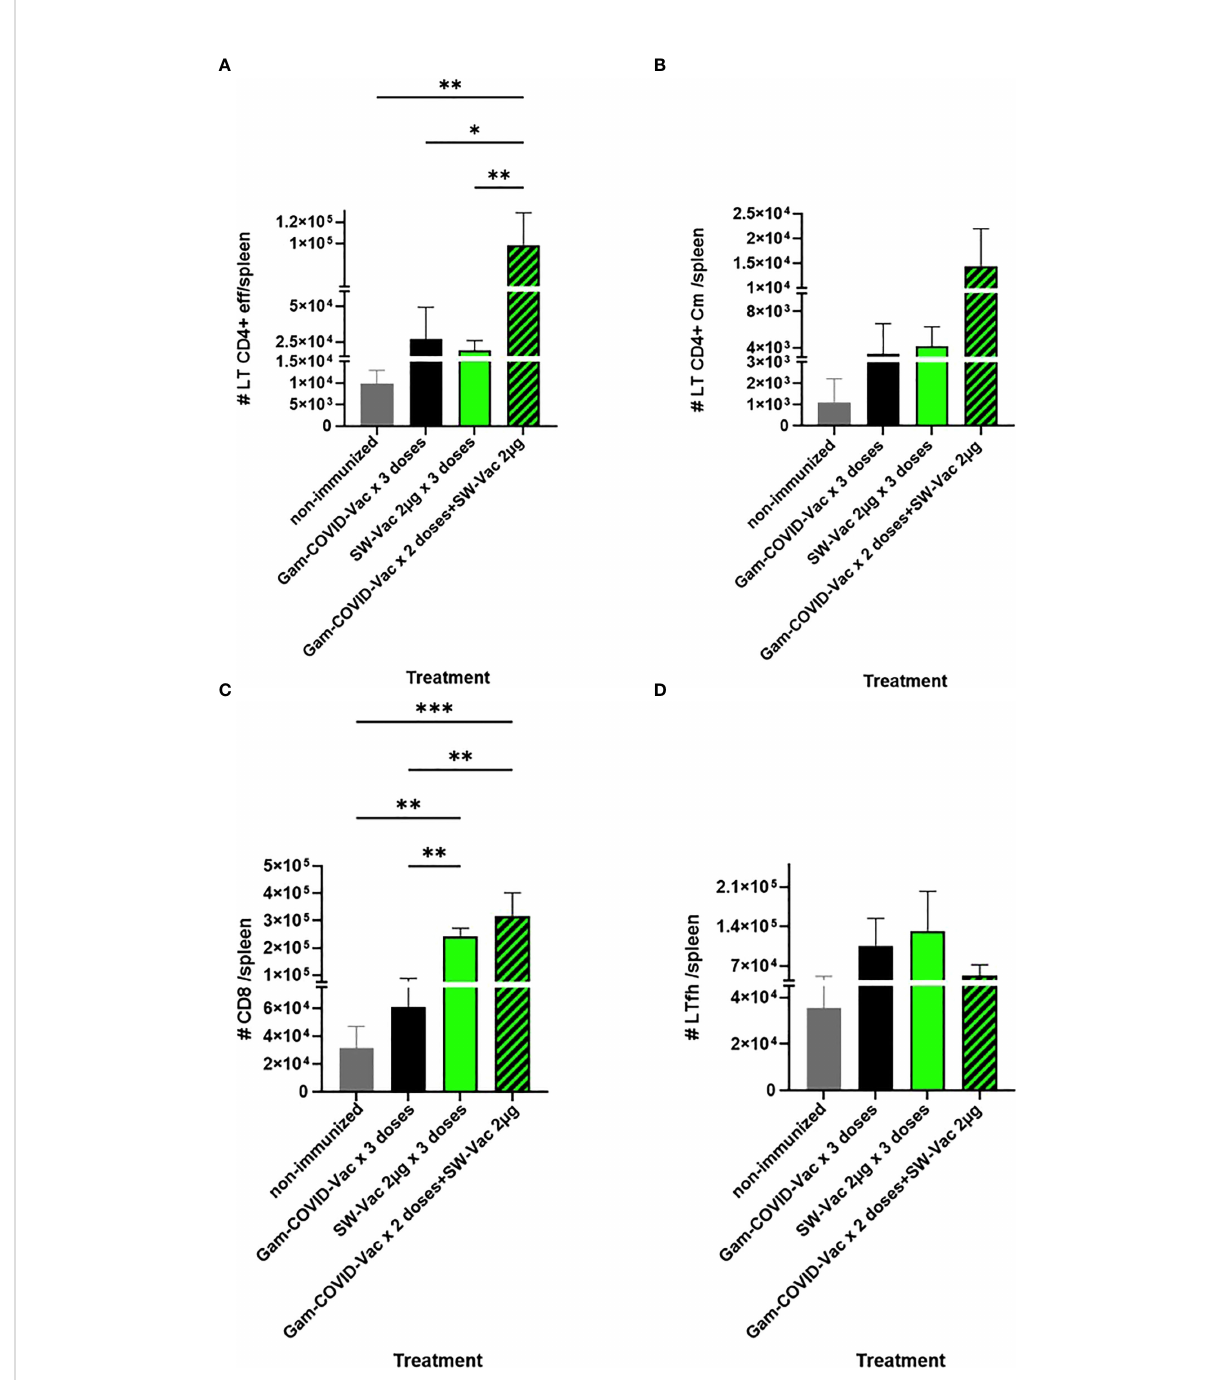
FIGURE 9 Flow cytometry analysis of spleen cells from immunized (3-doses schedules) or non-immunized mice were incubated with CD16/CD32 FcgRIII (1:100) to block IgG Fc receptors. Cells were incubated with LIVE/DEAD Violet (Invitrogen), followed by surface staining with fl uorochrome- conjugated anti-mouse Abs for various markers: CD3-Pe-Cy7 (BD), CD8-PE (BD), CD4-FITC (BD), CD44-PE (BD), CXCR5-PerCP-Cy5.5 (BD), CD127-APC (BD); CD4 + effector: CD3 + CD4 + CD62L - CD44 + (A) ; CD4 + Cm: CD3 + CD4 + CD62L + CD44 + (B) ; CD8 + : CD3 + CD8 + (C) ; Tfh: CD3 + CD4 + CXCR5 + (D) Flow cytometry analysis was performed on an BD FACSAria Fusion. The results were analyzed using FlowJo software (TreeStar).*p<0.05, **p<0.01, ***p<0.001 t-test. Results are representative of two independent